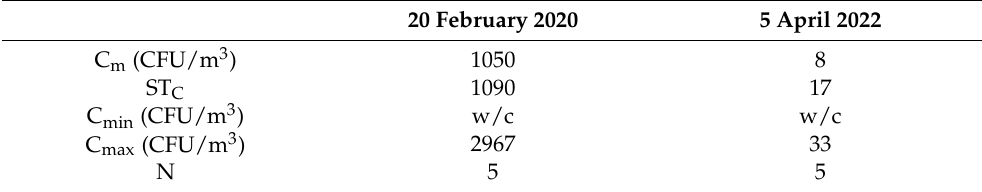
Table 3. Average E. coli concentration per m 3 of air (Cm, CFU/m 3 ), concentration standard deviation (ST C ), minimum concentration E. coli per m 3 of air (C min , CFU/m 3 ), maximum concentration per m 3 of air (C max , CFU/m 3 ), number of samples (N) within the LPR pens. Sampling dates: 20